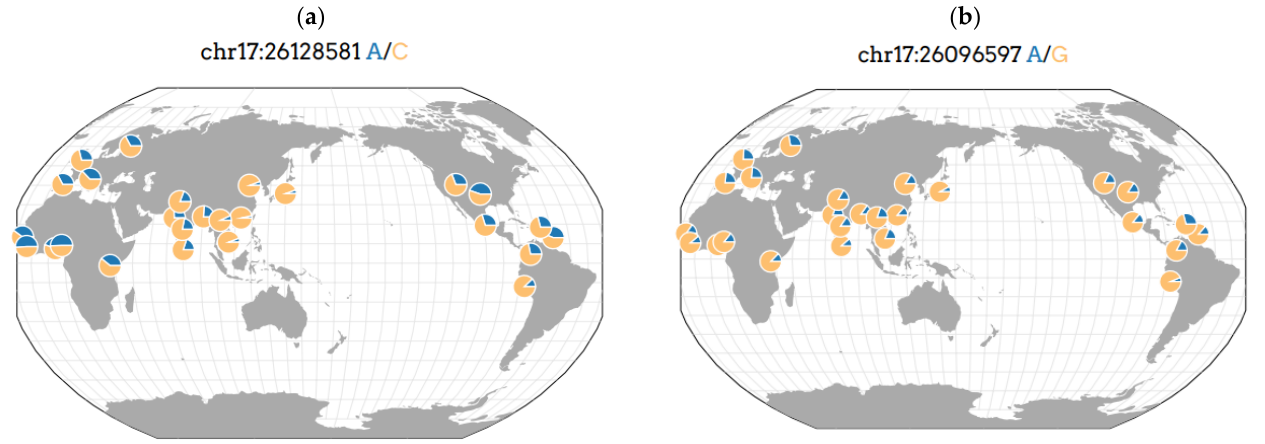
Figure 2. Geography of genetic variant rs2779249 ( a ) and rs2297518 ( b ) of the NOS2 gene in the world [51]. Note: blue color — minor allele; orange color — major allele.